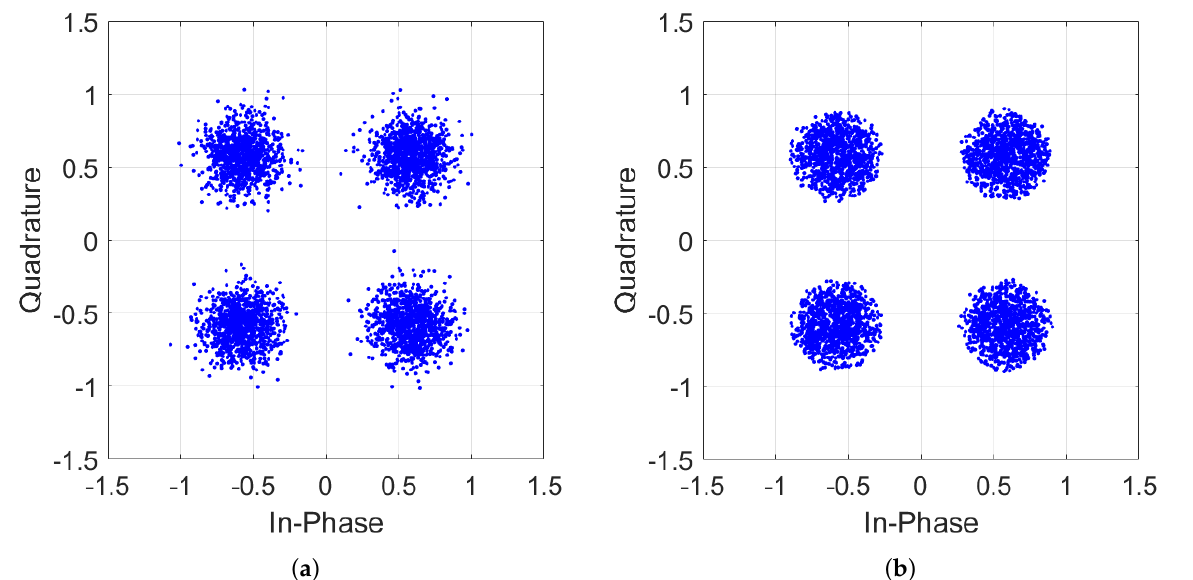
Figure 5. Array of four omnidirectional antennas along the x-axis, spacing λ /2. QPSK modulation, φ 0 = 90 ◦ , SNR( φ 0 ) = ∞ , PE DDM = 75%, P = 1024. Transmitted symbols for DDM in observation angle φ = 80 ◦ . ( a ) Zero mean artificial Gaussian noise. ( b ) Zero mean artificial Non-Gaussian noise (constant magnitude and random phase).